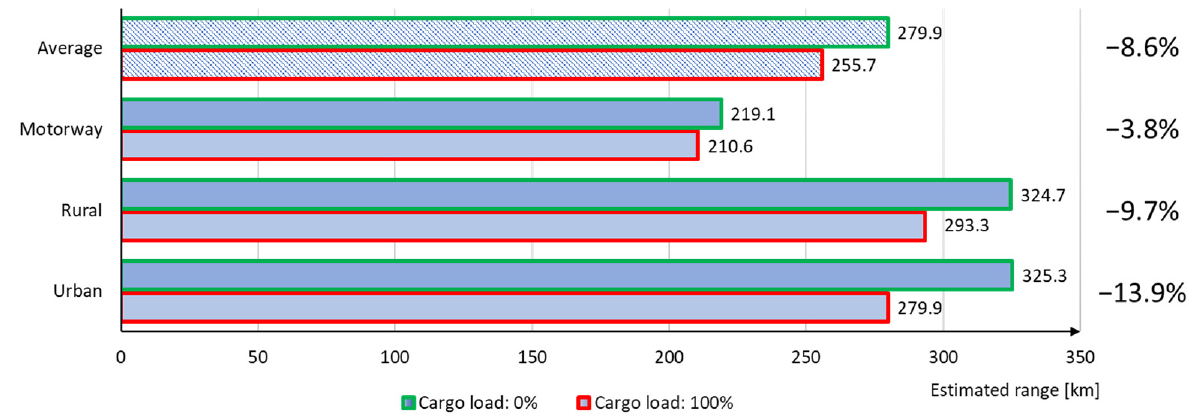
Figure 22. Effect of cargo weight on estimated range in different phases of the RDC test.